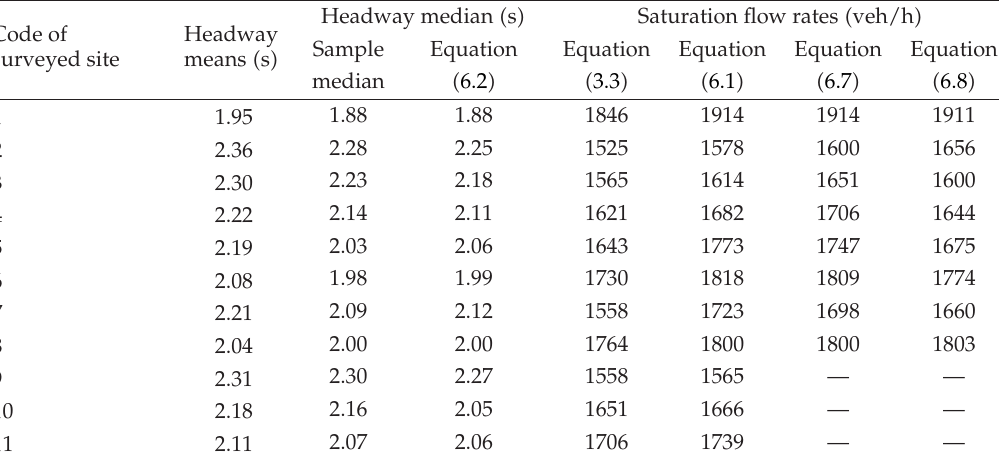
Table 3: Comparison of computed saturations using di ff erent